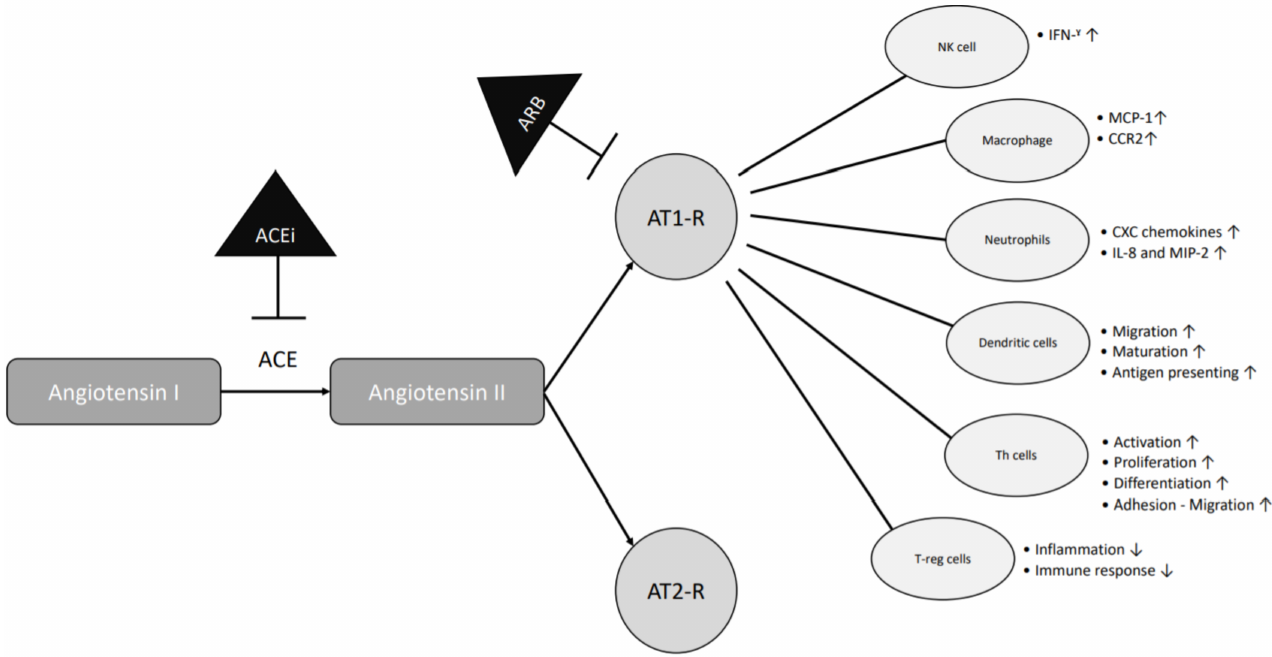
Figure 1. Anti-inflammatory mechanisms shared by ACE inhibitors and ARBs. ACE = angiotensin-converting enzyme; ACEi = angiotensin-converting enzyme inhibitor; AT1-R = angiotensin receptor type 1; AT2-R = angiotensin receptor type 2; ARB = angiotensin receptor type 1 inhibitor; NK = natural killer; Th = T helper cells; T-reg = T regulatory cells; IFN = interferon; MCP-1 = monocyte chemoattractant protein -1; CCR2 = C-C chemokine receptor 2; CXC = chemokines; IL-8 = interleukin-8; MIP-2 = macrophage inflammatory